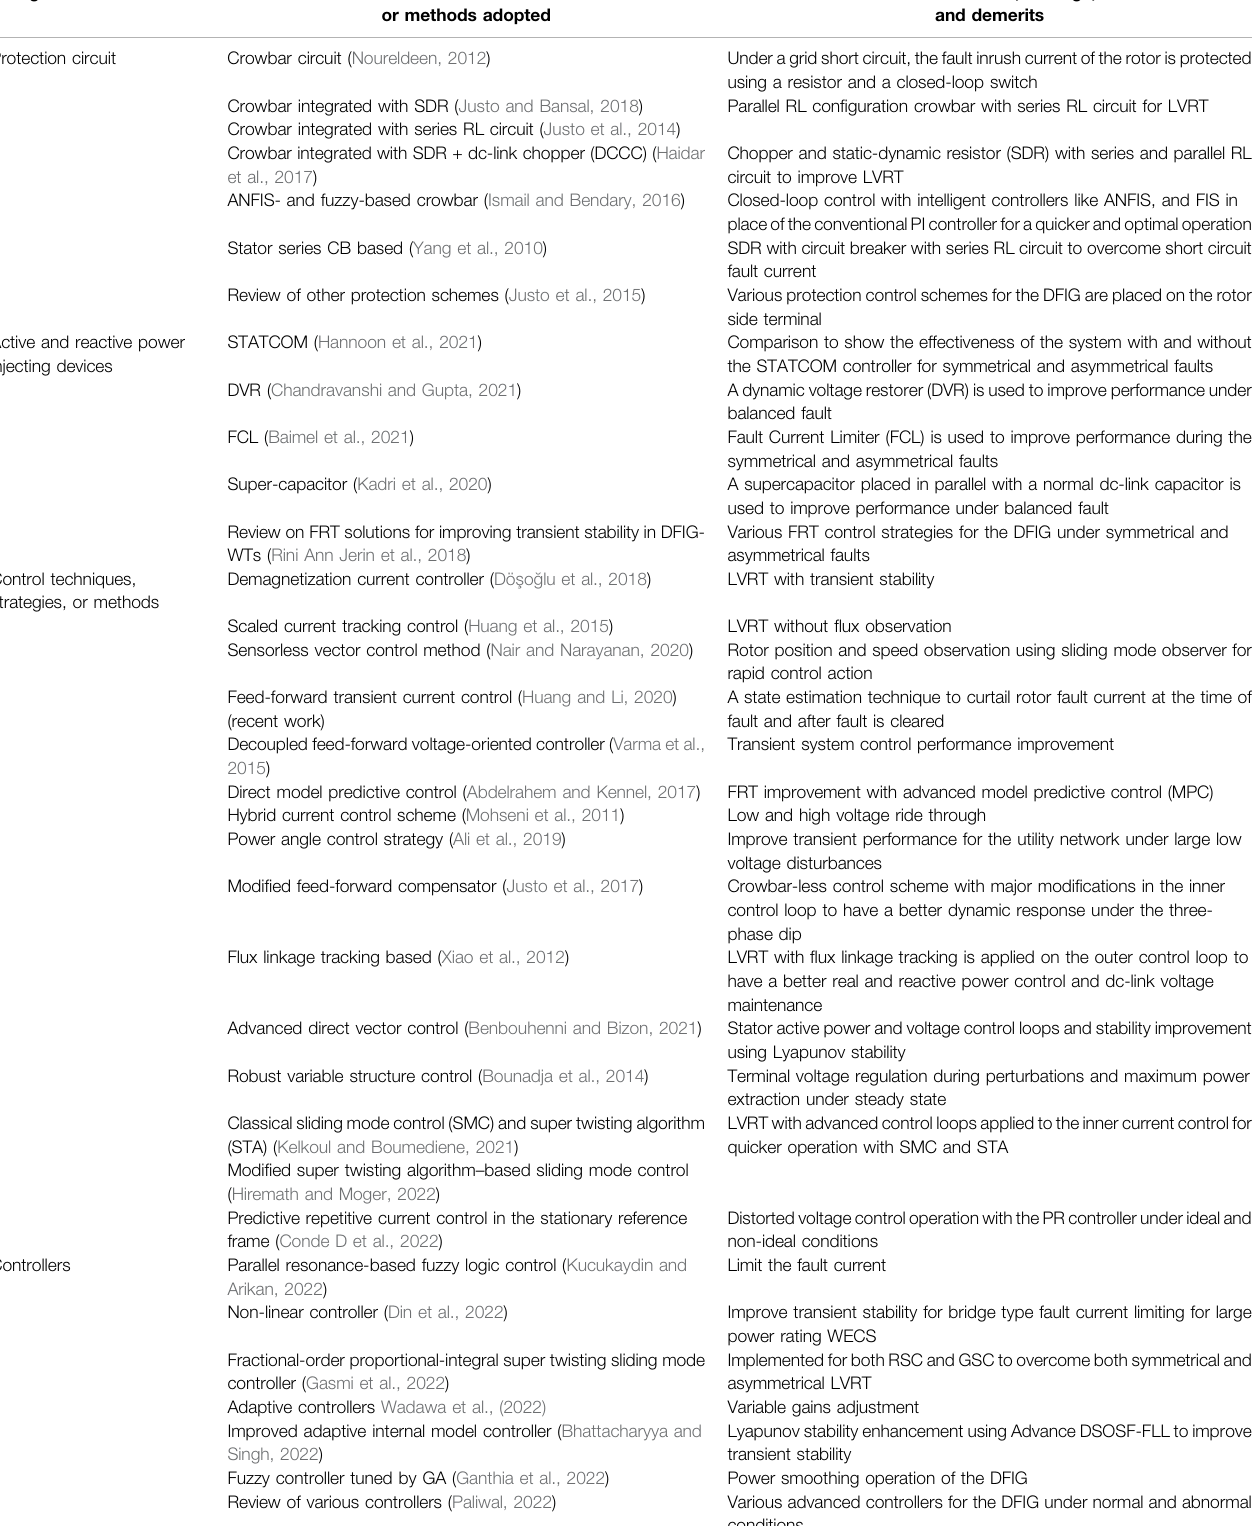
TABLE 1 | Summary of various DFIG VSC-based strategies under normal and abnormal grid conditions. Categories of